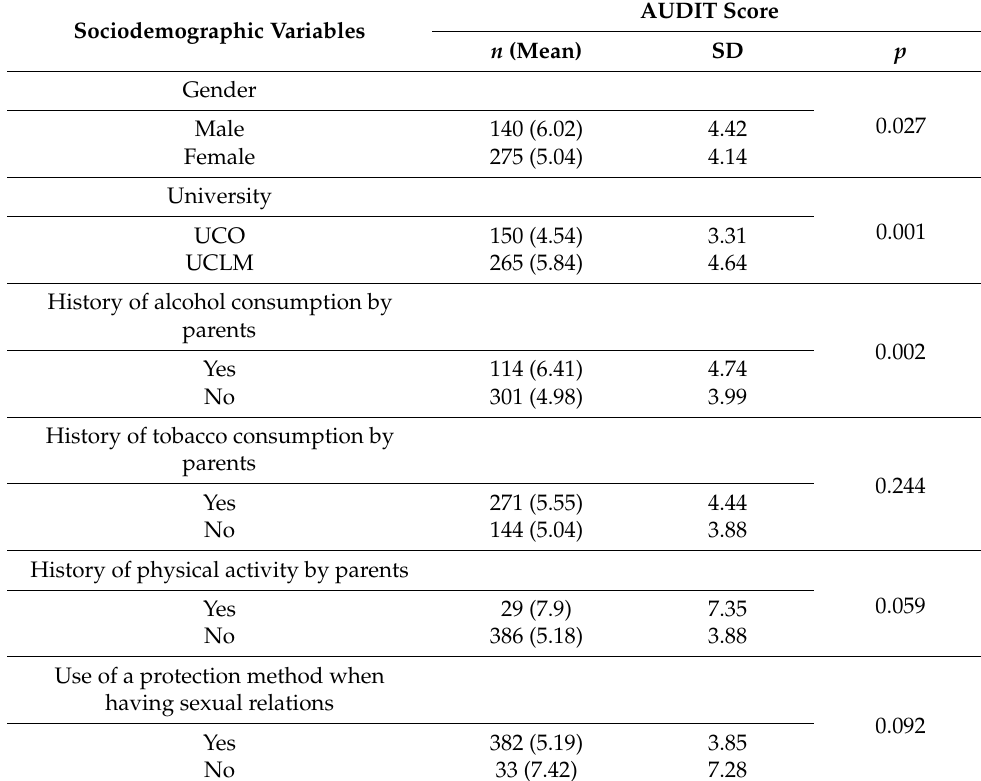
Table 1. Sociodemographic variables and AUDIT